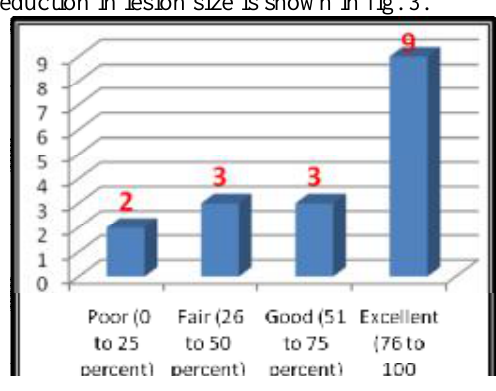
Fig. 2: The number of patients in relation to the amount of decrease in lesion size.